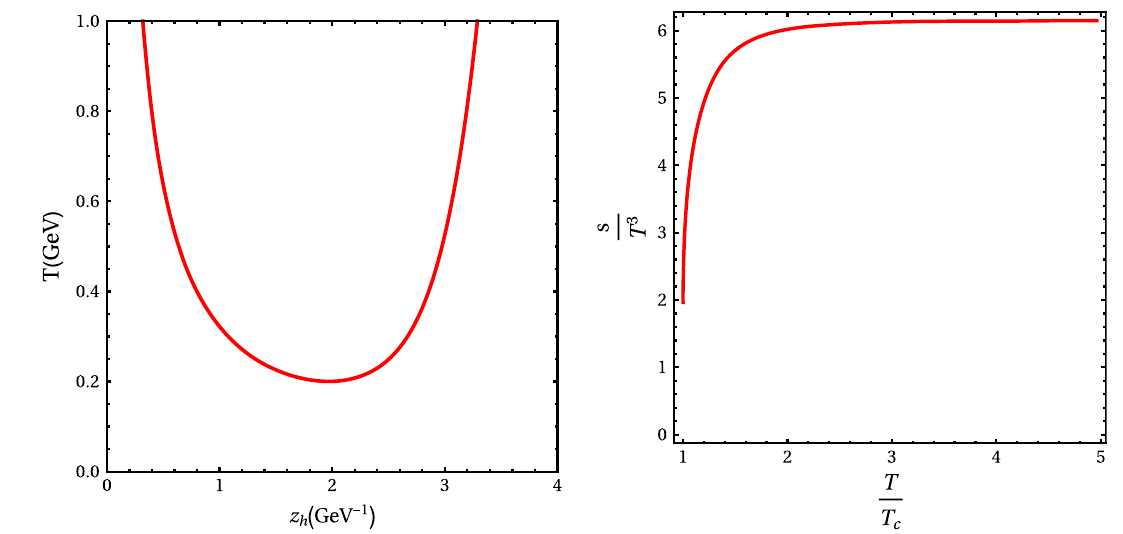
Fig. 1 The left panel shows the temperature T as a function of the black-hole horizon z h with k = 0 . 43GeV. In the right panel we present the scaled entropy density s / T 3 as a function of scaled temperature T / T c with k = 0 . 43GeV and G 5 / L 3 = 1 .